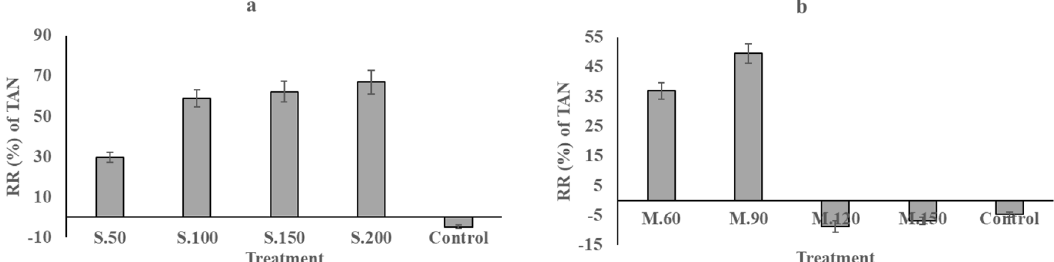
Fig. 5. The removal rates, averages and error bars of the four replications, of TAN (%) in the control and at four densities of both G. verucosa (a) and P. viridis (b).